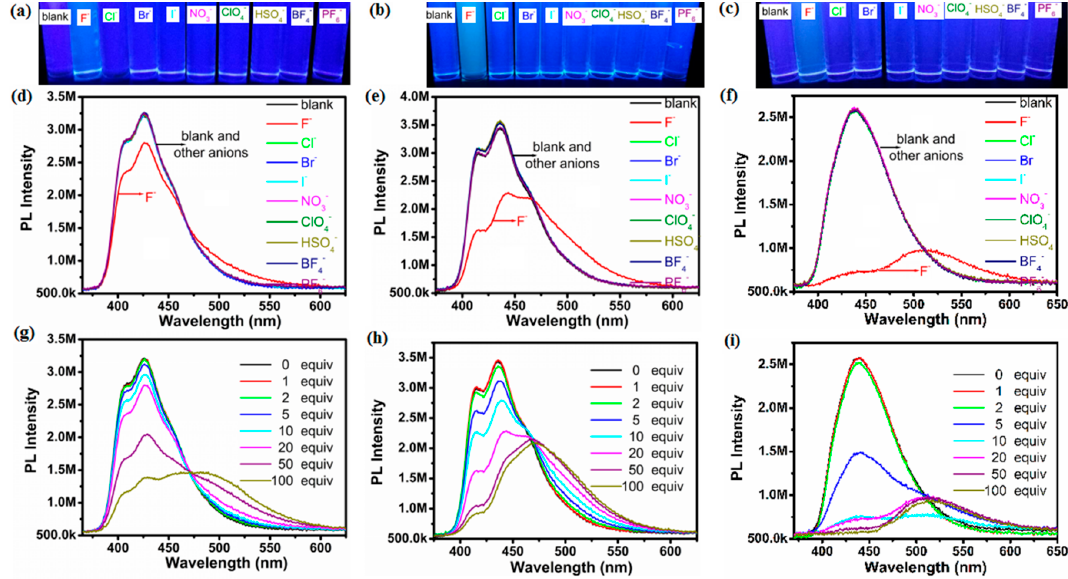
Figure 3. Photographs of the DMSO solutions of ( a ) compound 1a ; ( b ) compound 1b ; and ( c ) compound 1c (10 − 5 mol L − 1 ) in the absence (blank) and presence of nine anions (20 equiv.) taken under UV light at 365 nm. Emission spectra of DMSO solutions of ( d ) compound 1a ; ( e ) compound 1b , and ( f ) compound 1c (10 − 5 mol L − 1 ) in the absence (blank) and presence of nine anions (20 equiv.). UV/Vis absorption spectra of DMSO solutions of ( g ) compound 1a ; ( h ) compound 1b ; and ( i ) compound 1c (10 − 5 mol L − 1 ) with different amounts of Bu 4 N + F − .